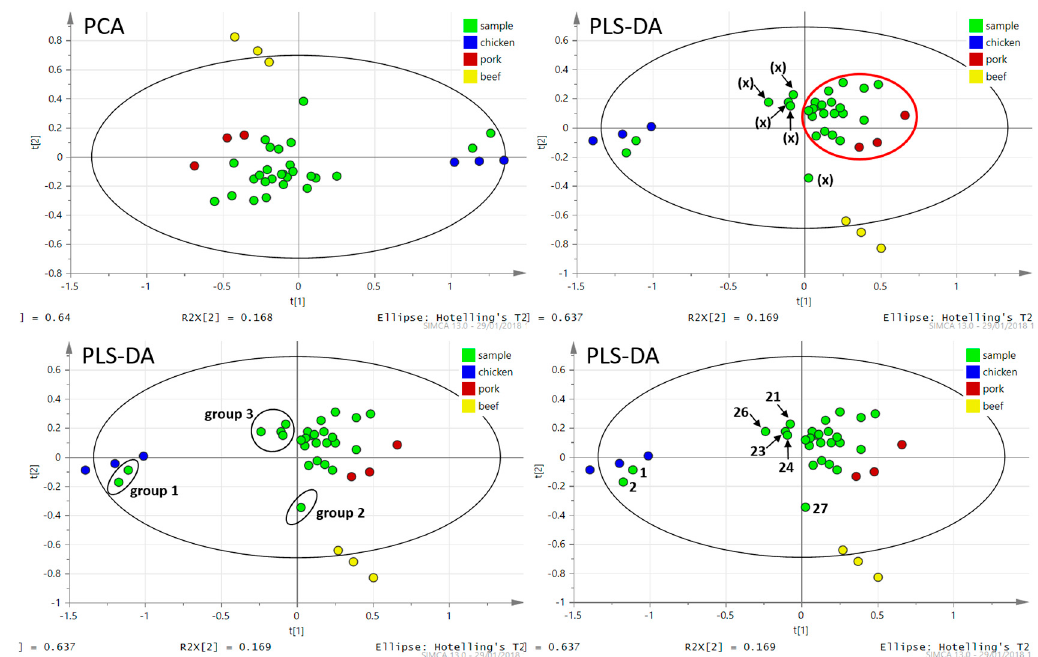
Figure 4. PCA and PLS-DA plots created from ions related to triacylglycerols present in hexane extracts of meat products (green), chicken (blue), pork (red) and beef (yellow). Group 1—chicken ham samples; group 2—meat products containing 70% of beef; group 3—pork meat products containing mechanically separated chicken meat and the rest of the green points represent meat products based on pork meat.